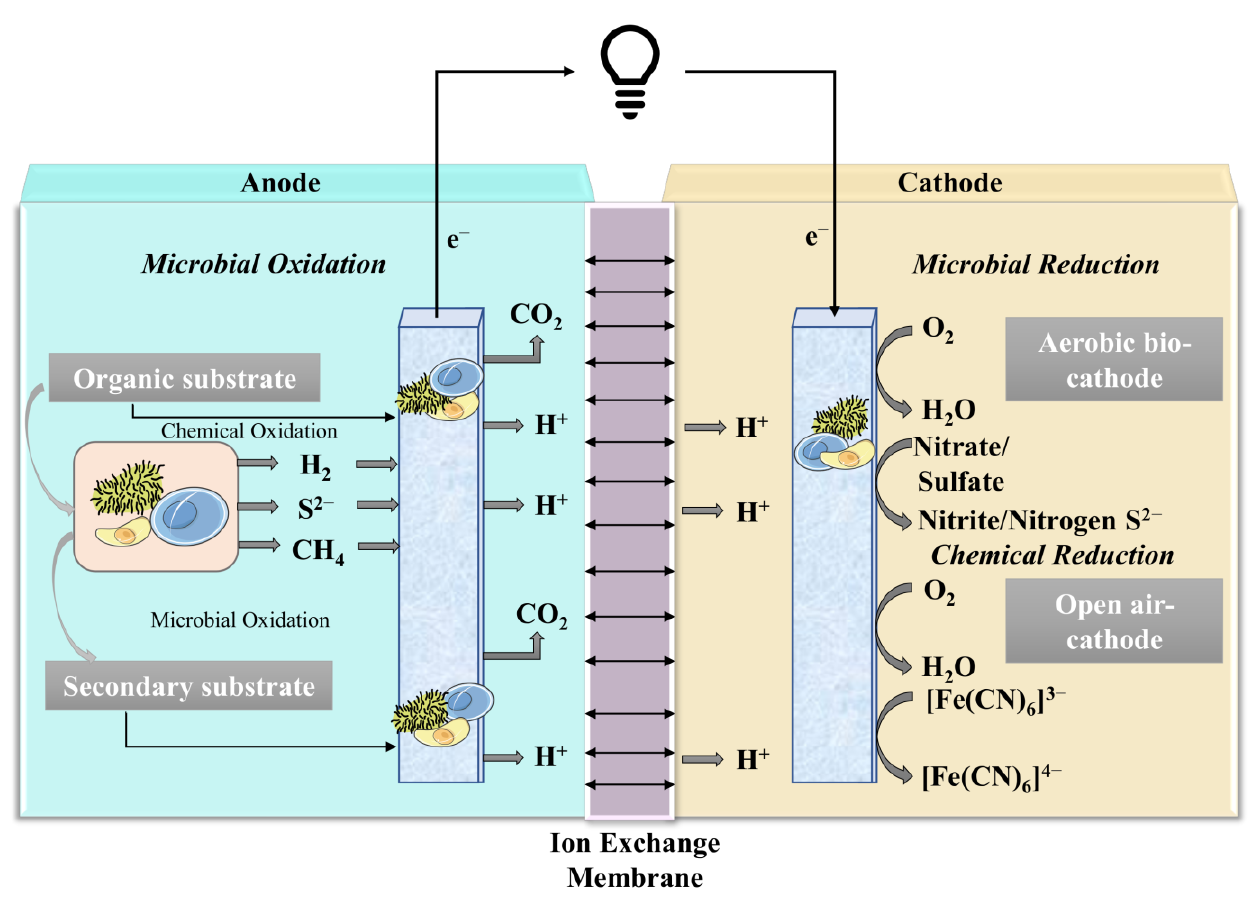
Figure 3. Working principles of MFCs.